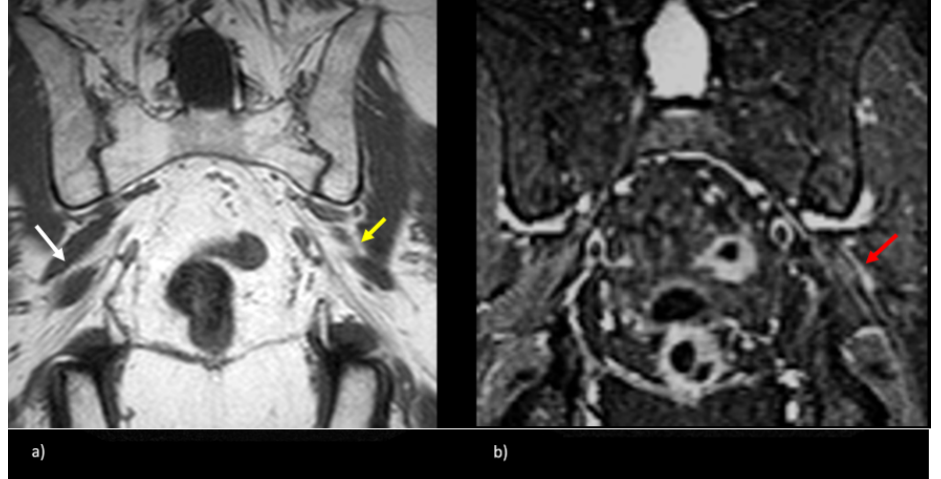
Figure 5. Patient presented with left-sided symptoms and lumbosacral plexus MRN showing bilateral type II variants: ( a ) coronal T1-weighted sequence showing right-sided sciatic nerve split around the normal right (white arrow) and atrophied left (yellow arrow) piriformis muscle; ( b ) coronal STIR sequence demonstrating increased signal of the left sciatic nerve (red arrow).